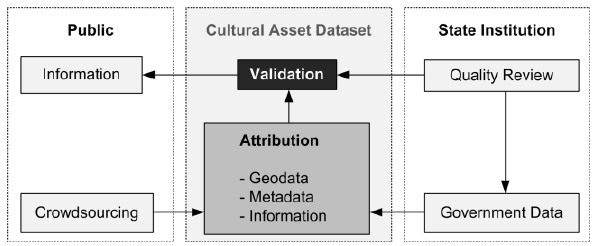
Figure 5. Administrative quality management in KuLIS